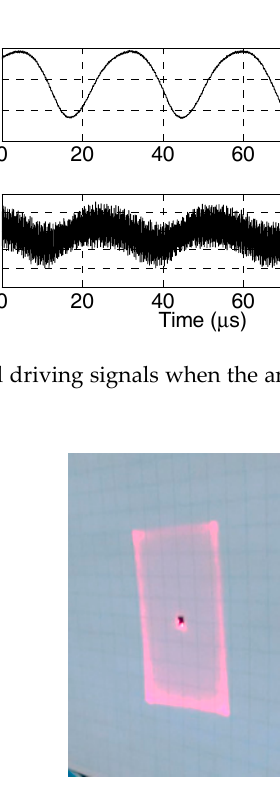
Figure 6. Measured frequency response of the electromagnetically-driven piezoresistively sensed scanning mirror.